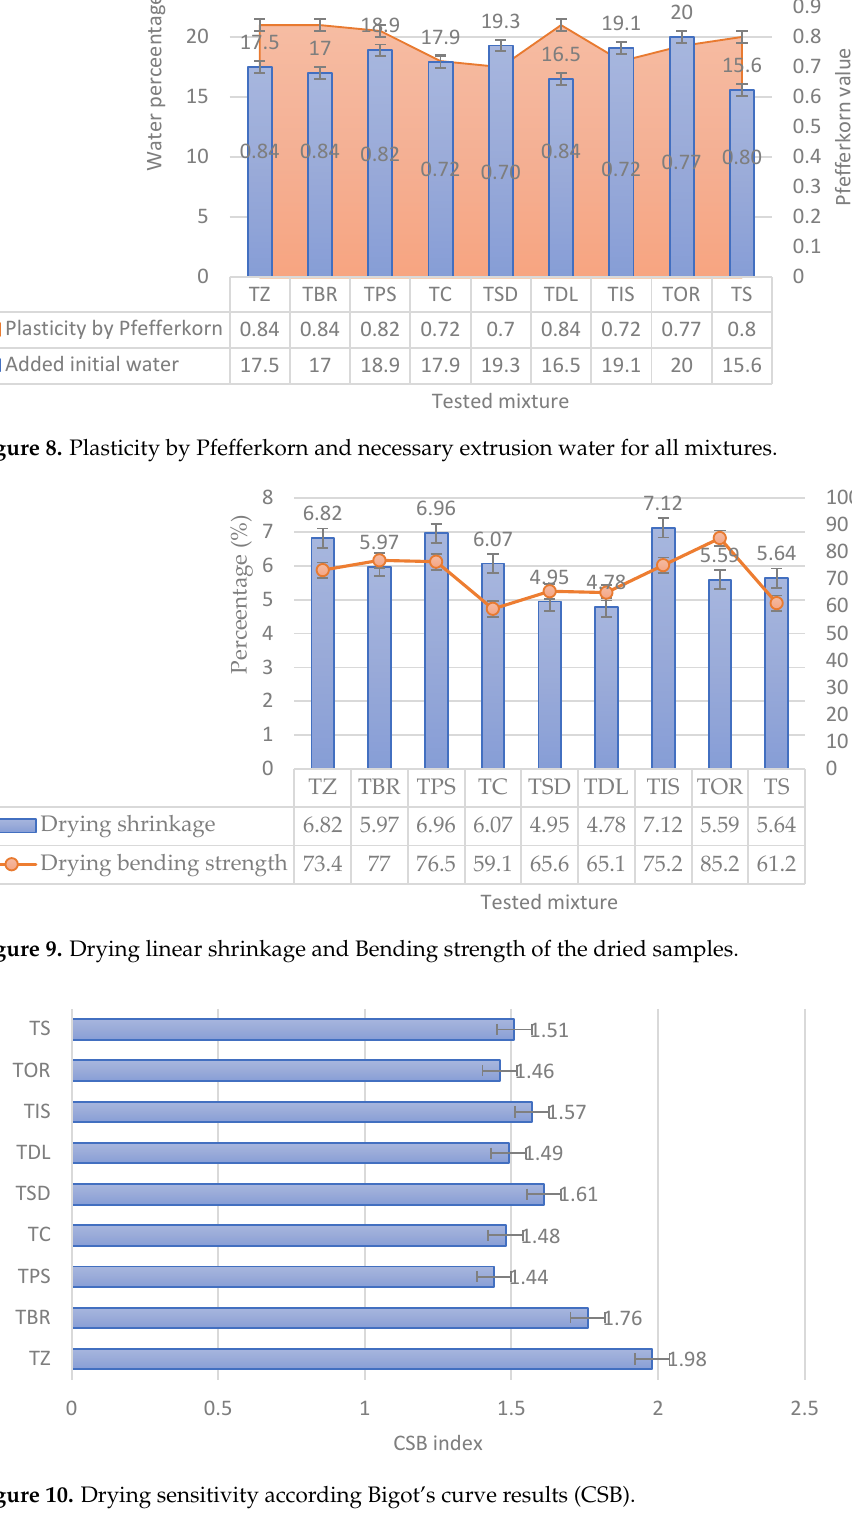
Figure 10. Drying sensitivity according Bigot’s curve results (CSB).